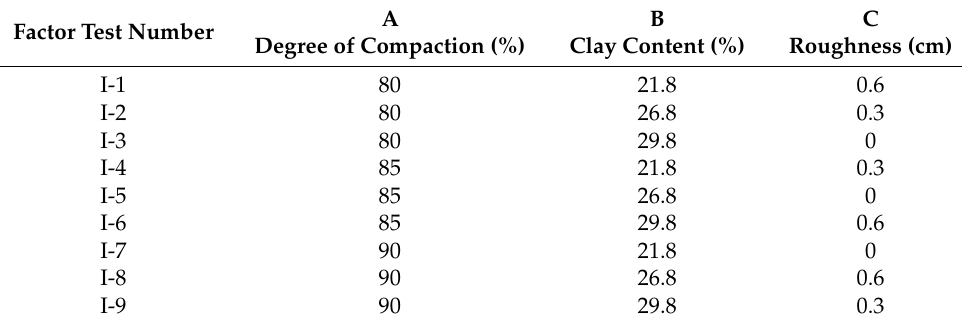
Table 3. Testing scheme of orthogonal tests.